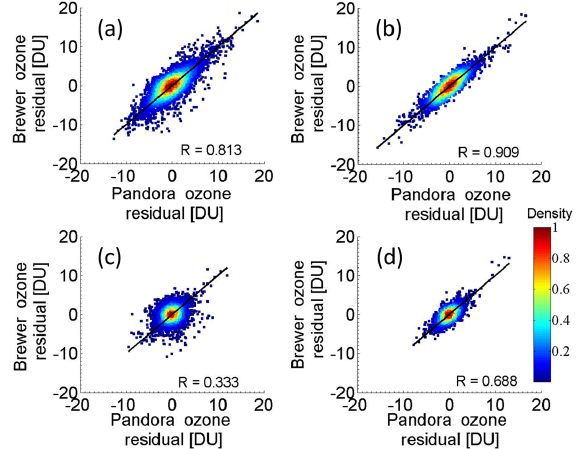
Figure 4. Scatter plots for residual ozone type 1 and 2, colour-coded by the normalized density of the points. (a) Brewer no. 8 vs. Pan- dora no. 103 (residual type 1), (b) Brewer no. 8 vs. Pandora no. 104 (residual type 1), (c) Brewer no. 8 vs. Pandora no. 103 (residual type 2), (d) Brewer no. 8 vs. Pandora no. 104 (residual type 2). The black line is the one-to-one